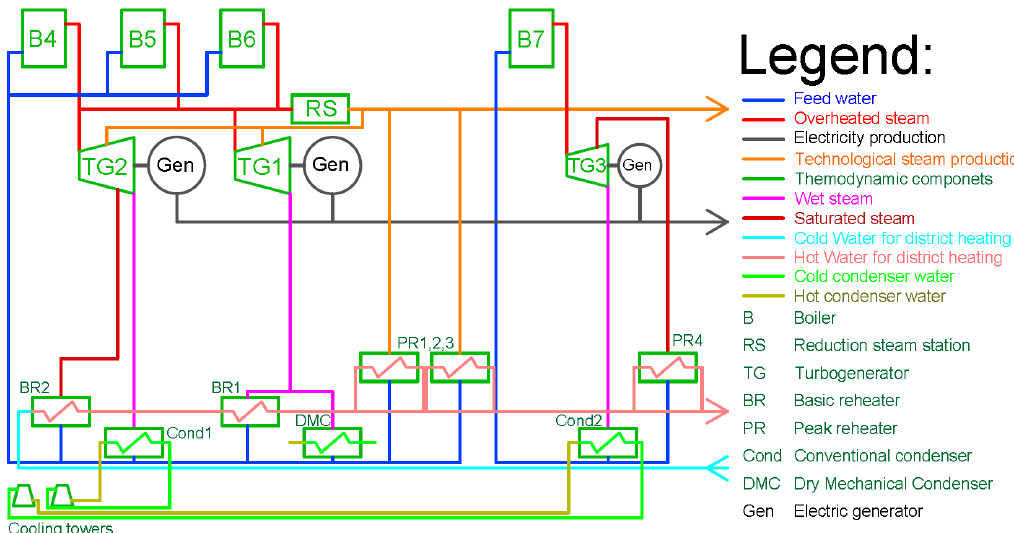
Figure 1. Actual technological flowsheet of cogeneration power plant in Pilsen [4].